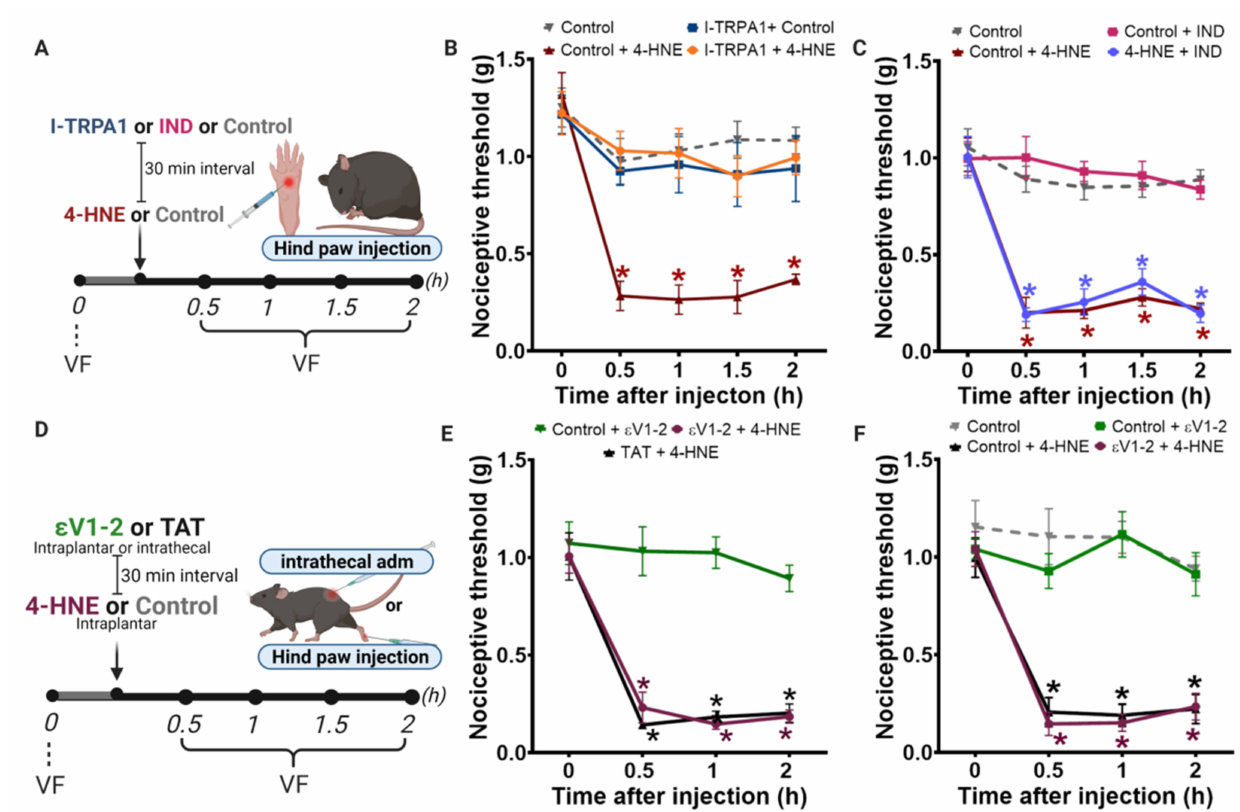
Figure 5. TRPA1 is involved in 4-HNE-induced nociception and the global PKC ε antagonist does not prevent this hy- persensitivity effect. ( A ) Schematic panel of drug administration and von Frey filament (VF). ( B ) I-TRPA1 (HC 030031; 300 nmol/paw) or vehicle were administered 30 min before 4-HNE (60 nmol/paw). ( C ) Indomethacin (10 mg/kg, i.p) or vehicle (i.p) were administered 30 min before 4-HNE (60 nmol/paw). ( D ) Schematic panel of drug administration and von Frey filament (VF). ( E ) ε V1-2 (1 µ g/paw) i.pl. was administered 30 min before the injection of 4-HNE (60 nmol/paw) i.pl. ( F ) ε V1-2 (1.35 µ g/animal) i.t. was administered 15 min before 4-HNE (60 nmol/paw). Error bars represent mean ± SEM; n = 8 per condition. Two-way analyses of variance (ANOVA) with post-hoc testing by Tukey. * p < 0.05 when compared with the baseline (time 0). Pain assessment was carried out by an observer blinded to the experimental